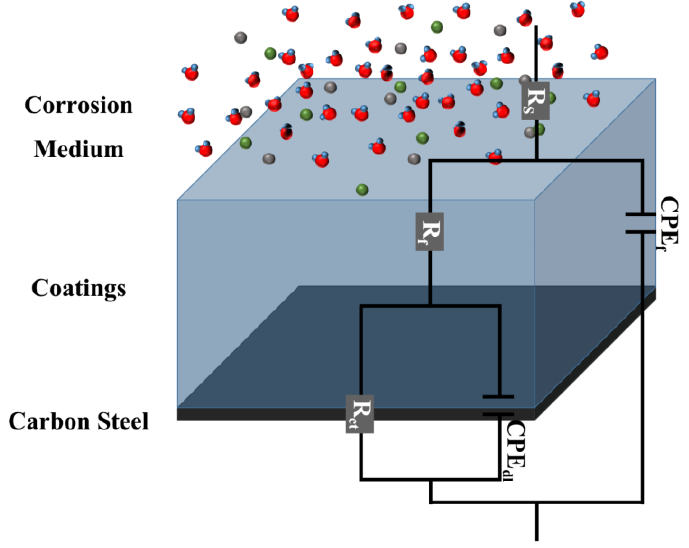
Figure 13. The proposed equivalent electrical circuit of coatings according to the impedance data. Table 3. Electrochemical impedance spectra data of different coatings for different immersion